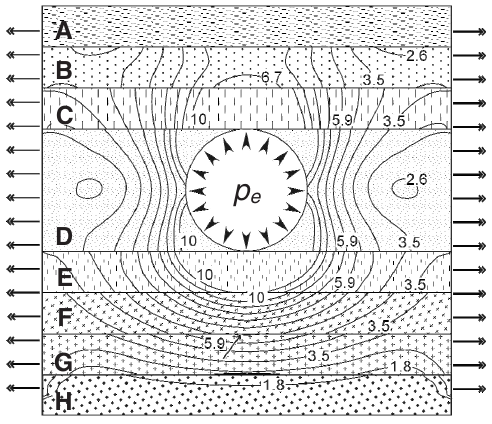
Fig. 17. Boundary-element model showing the con- tours, in MPa, of the maximum principal tensile stress around a magma chamber in a layered crust of a rift zone or a volcanic edifice. The model and layering is the same as in fig. 16 except that in addition to the magmatic excess pressure of 10 MPa there is a uni- form horizontal tension, as indicated by the horizontal arrows, of 3 MPa. This tension would apply to plate pull in rift zones and volcano spreading in